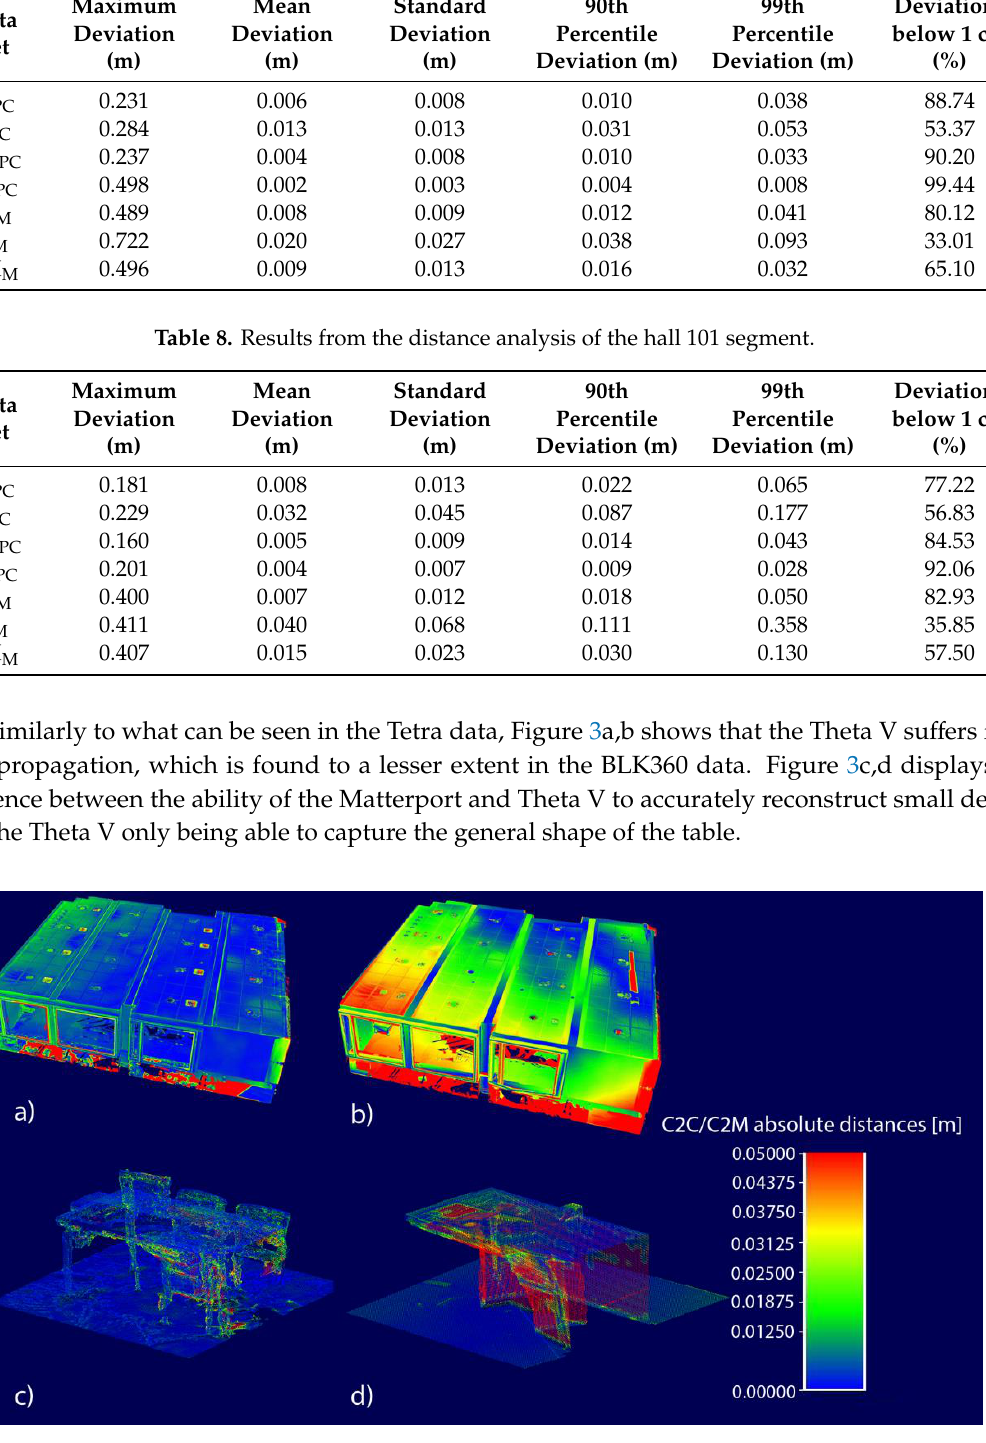
Table 7. Results from the distance analysis of the hall 101 room geometry.